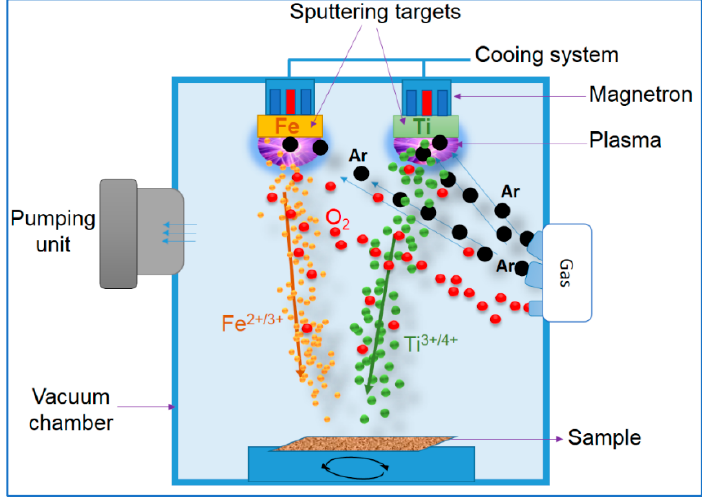
Figure 4. Schematic representation of the two target-sputtering units used to deposit the metal and oxides films in Ar atmosphere with a low residual concentration of air (O 2 ).